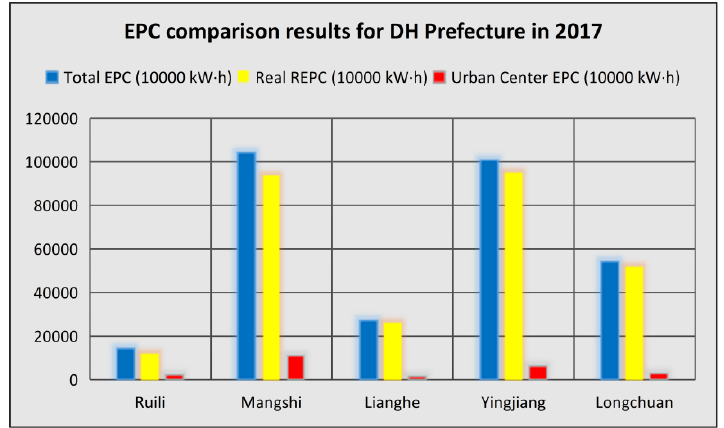
Figure 8. EPC comparison results for the DH Prefecture in 2017.